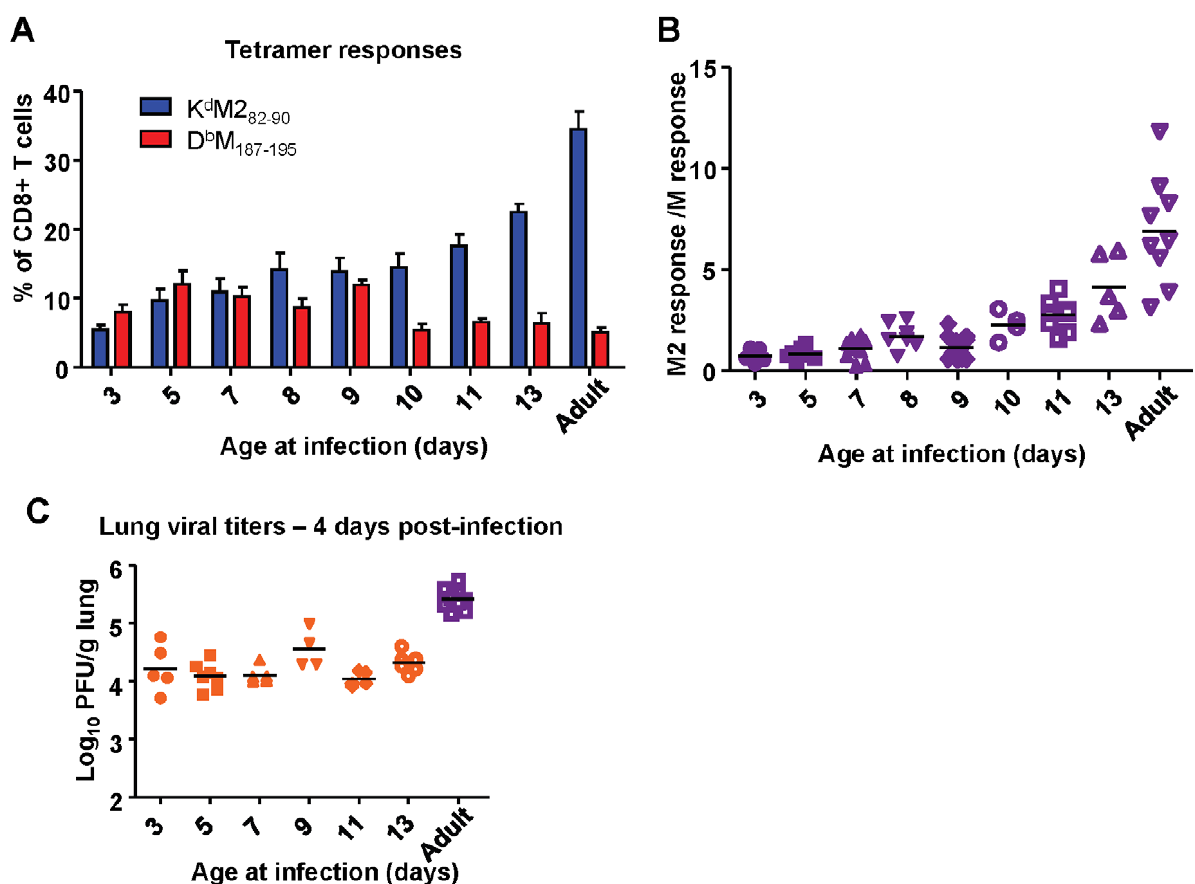
Figure 9. Age at infection determines CD8 + T cell epitope hierarchy. (A) K d M2 82-90 and D b M 187-195 epitope-specific CD8 + T cell responses determined by tetramer staining at day 7 post-infection of mice infected with RSV at the indicated day of life. (B) Epitope-specific CD8 + T cell response ratios at day 7 post-infection of mice infected with RSV at the indicated day of life. (C) Viral titers in the lung at day 4 post-infection of mice infected with RSV at the indicated day of life. Data represent two independent experiments with 4-8 mice/group. Error bars are the SEM.